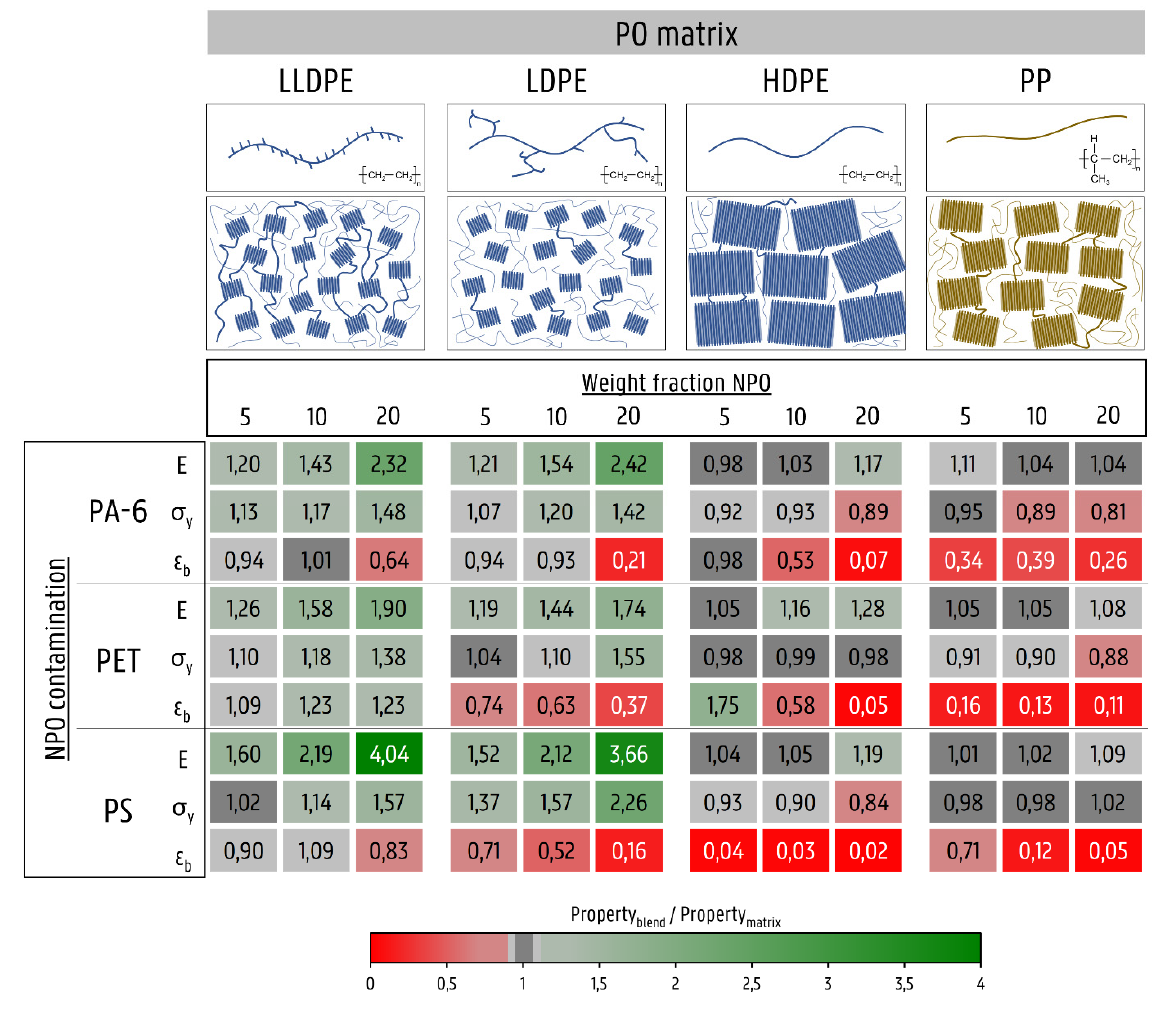
Figure 12. Overview of elastic modulus, yield strength, and strain at break for the PO matrices contaminated with PA-6, PET, and PS. The values shown are the ratios of the property of the blend to the property of the neat PO matrix.